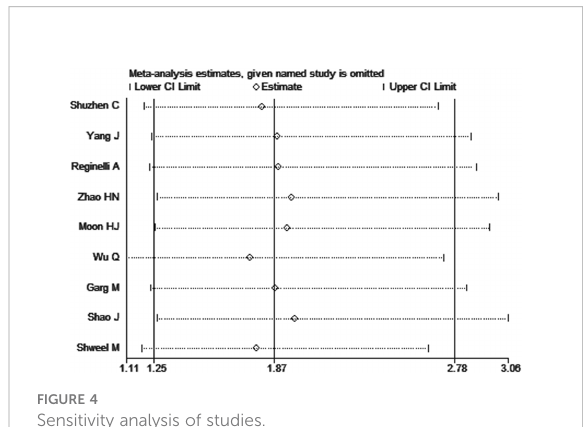
FIGURE 4 Sensitivity analysis of studies.